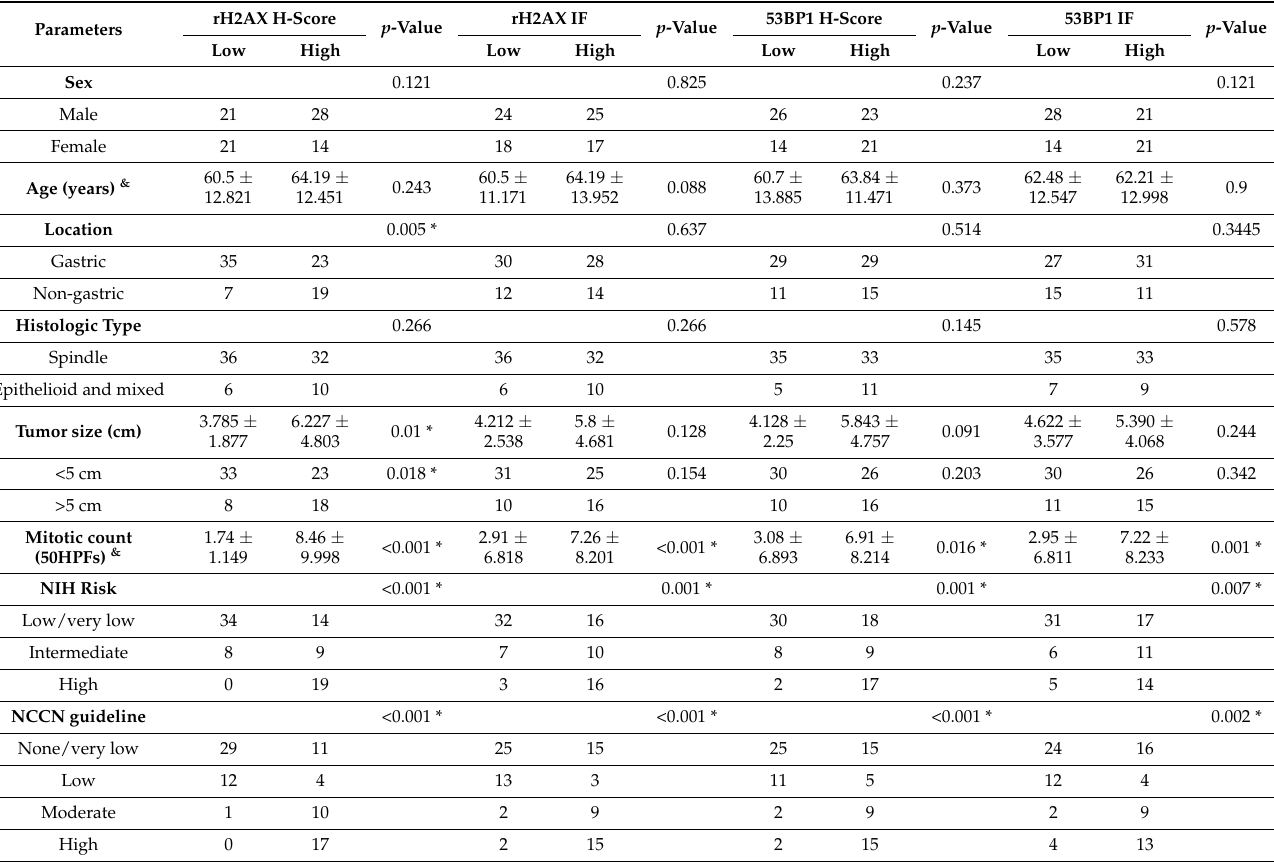
Table 1. Associations of various clinicopathologic parameters with rH2AX and 53BP1 expression levels by IHC and